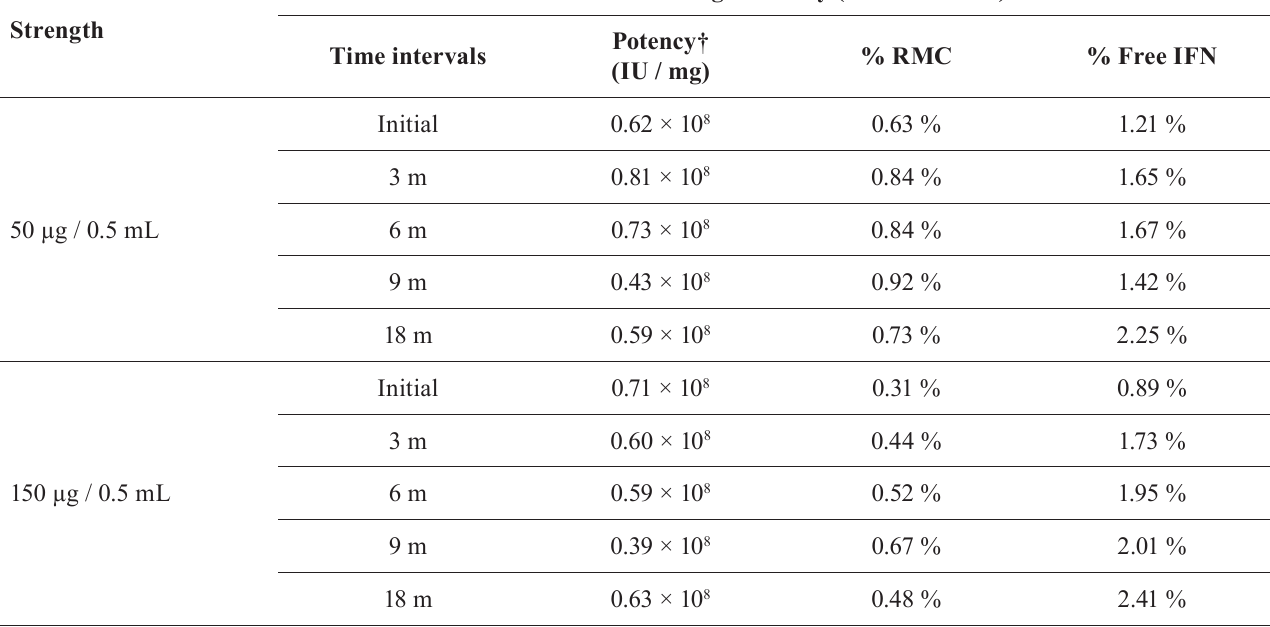
TABLE VII - Formulation D with two different strengths lyophilized using short lyophilization process